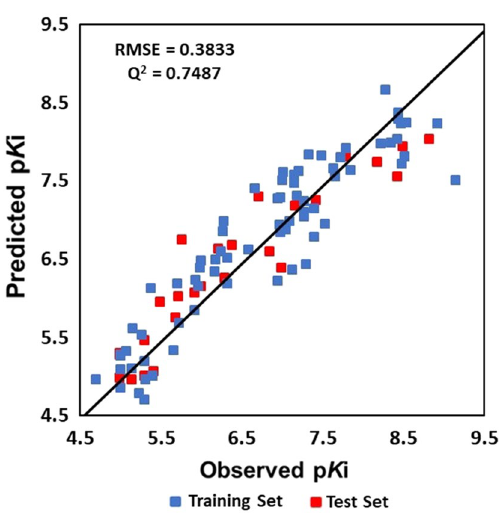
Fig. 7 Predicted and observed affinities for training set (blue) and test set (red) compounds using DKPLS models constructed from radial